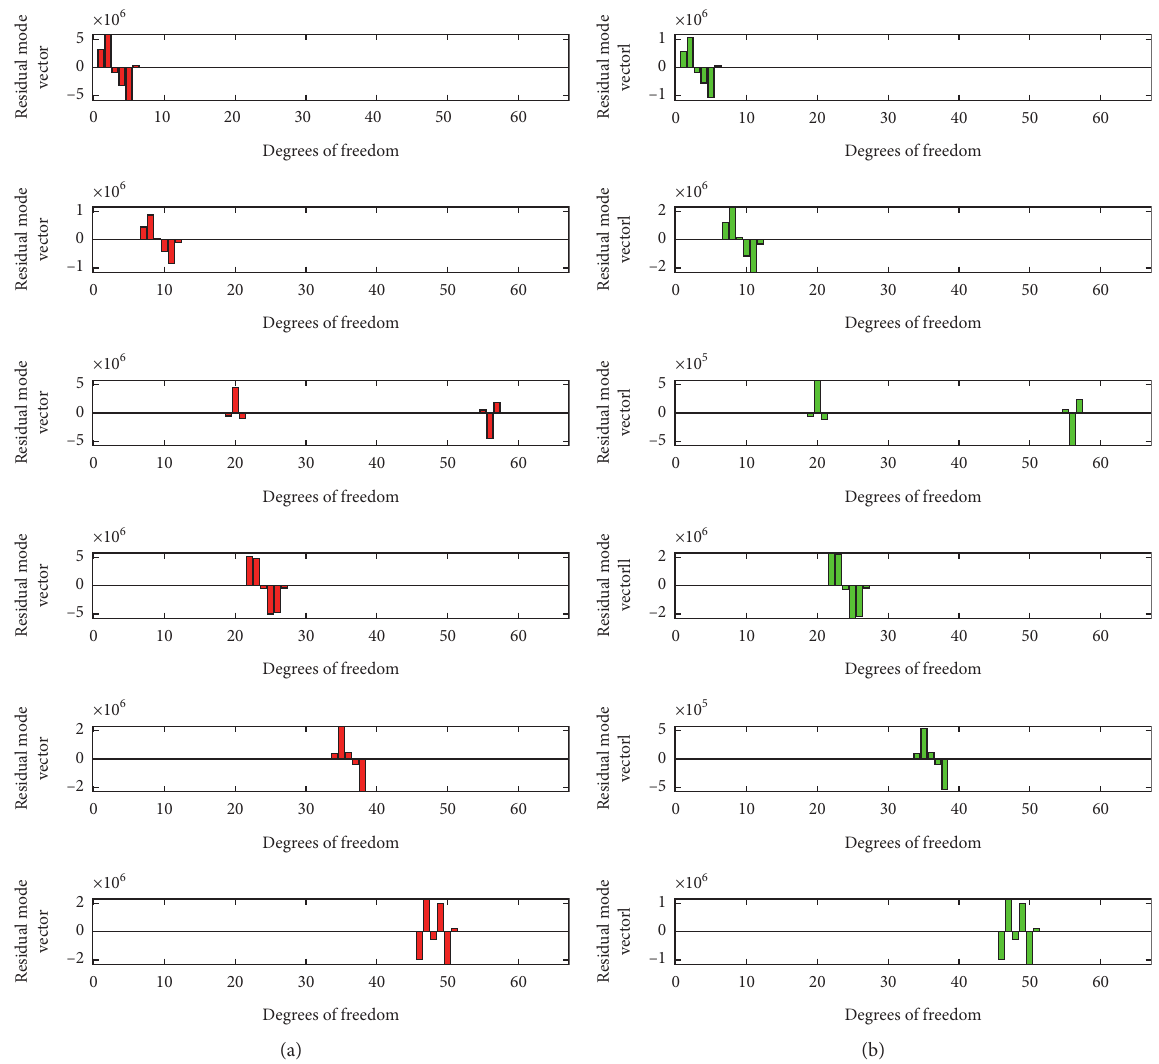
Figure 8: Component schematic diagram: (a) the amount of K